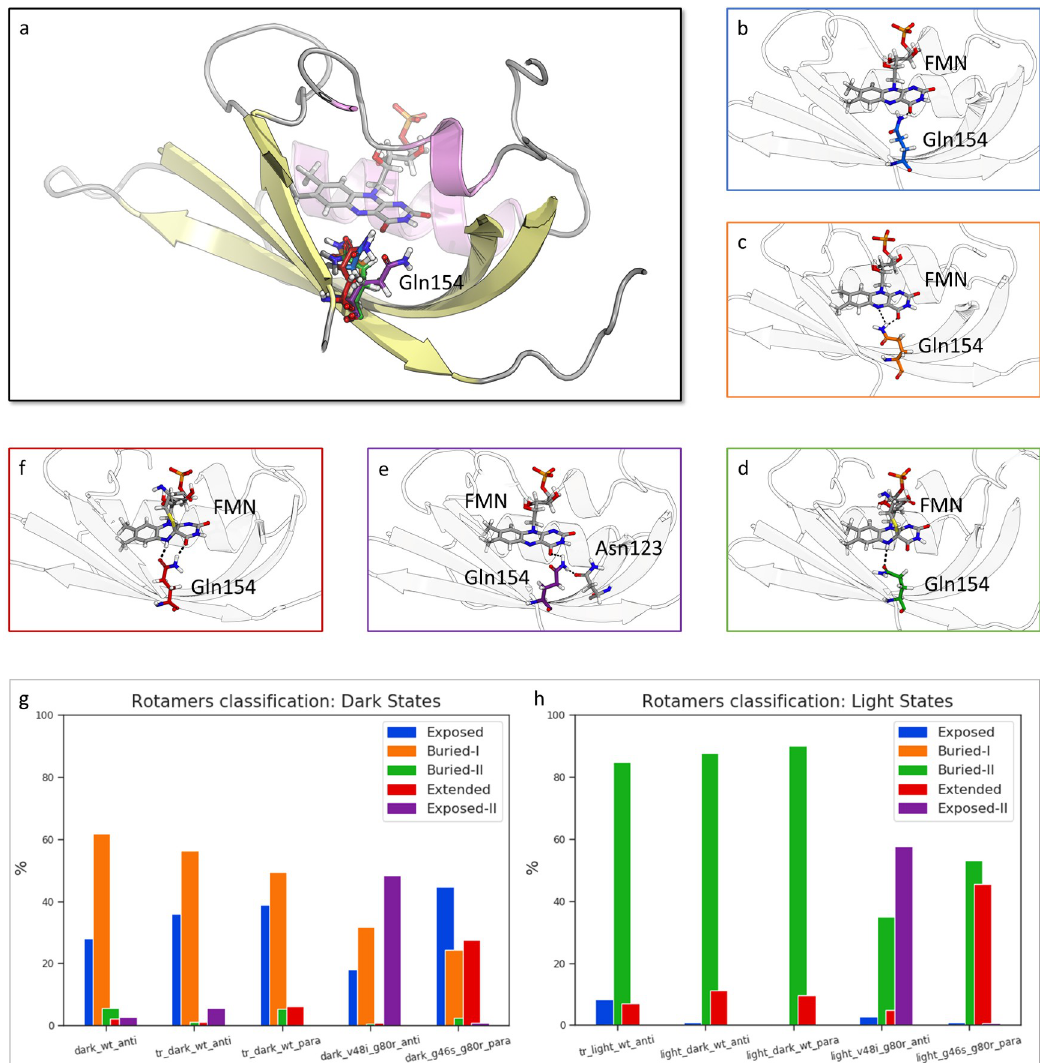
Fig 2. Conformational analysis of Gln154. a) Overlap of different Gln154 conformations. Representative Gln154 structures of b) Exposed conformation, c) Buried-I conformation, d) Buried-II conformation, e) Exposed-II conformation, f) Extended conformation. Hydrogen bonds formed by Gln154 shown in dashed line. g) Percentage of different conformations adopted by Gln154 during the simulations for ZTL structures in the dark state. h) Percentage of different conformations adopted by Gln154 during the simulations for ZTL structures in the light